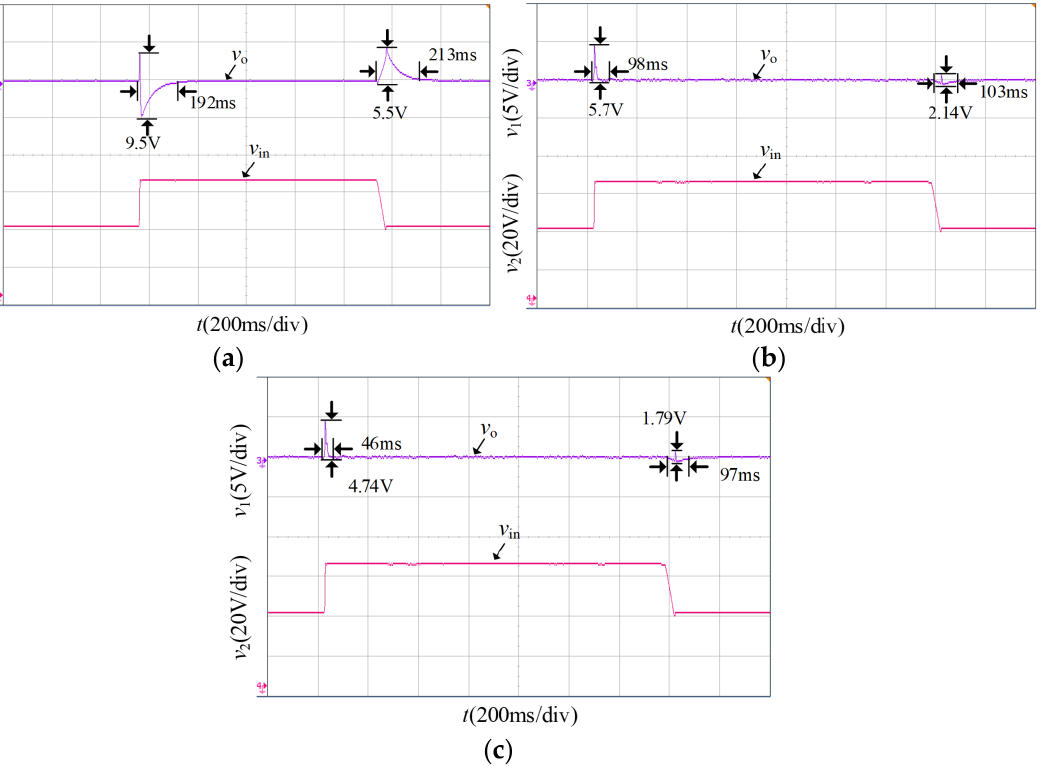
20 of 24 Figure 19. The efficiency curve of the prototype: ( a ) step-up mode; ( b ) step-down mode. It can be seen from Figure 19 that the efficiency of the two units is the highest. Alt- hough the period increases with the increase in the number of units, the stress of the switch tube decreases significantly, and the total loss decreases.